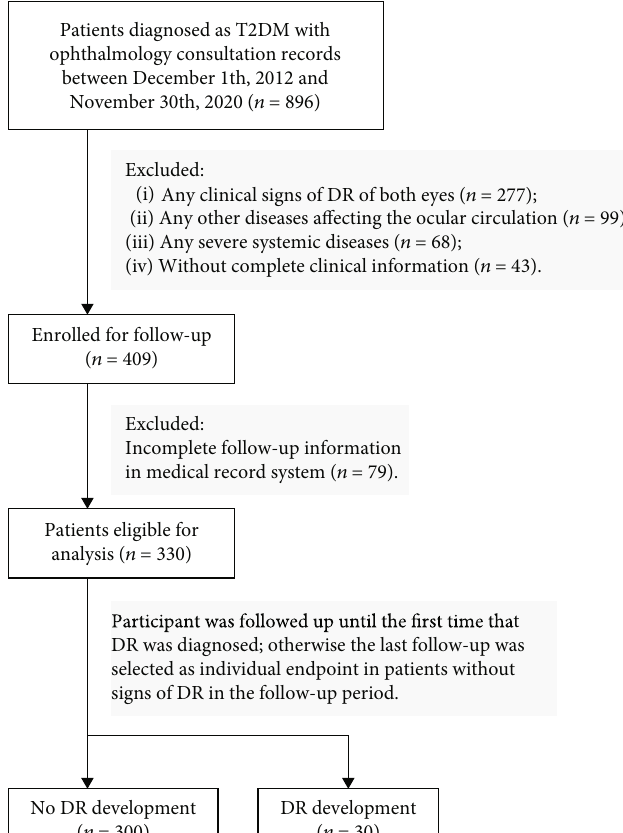
Figure 1: The distribution of study participants. T2DM: type 2 diabetes mellitus; DR: diabetic